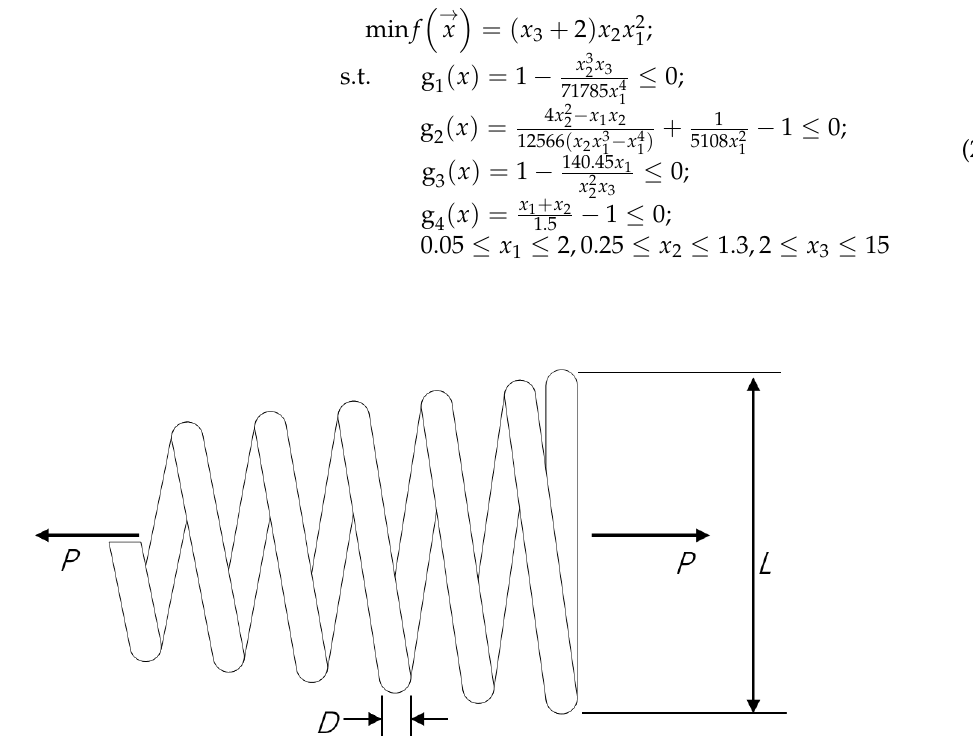
Table 10. Comparison results of six algorithms in spring design problem.